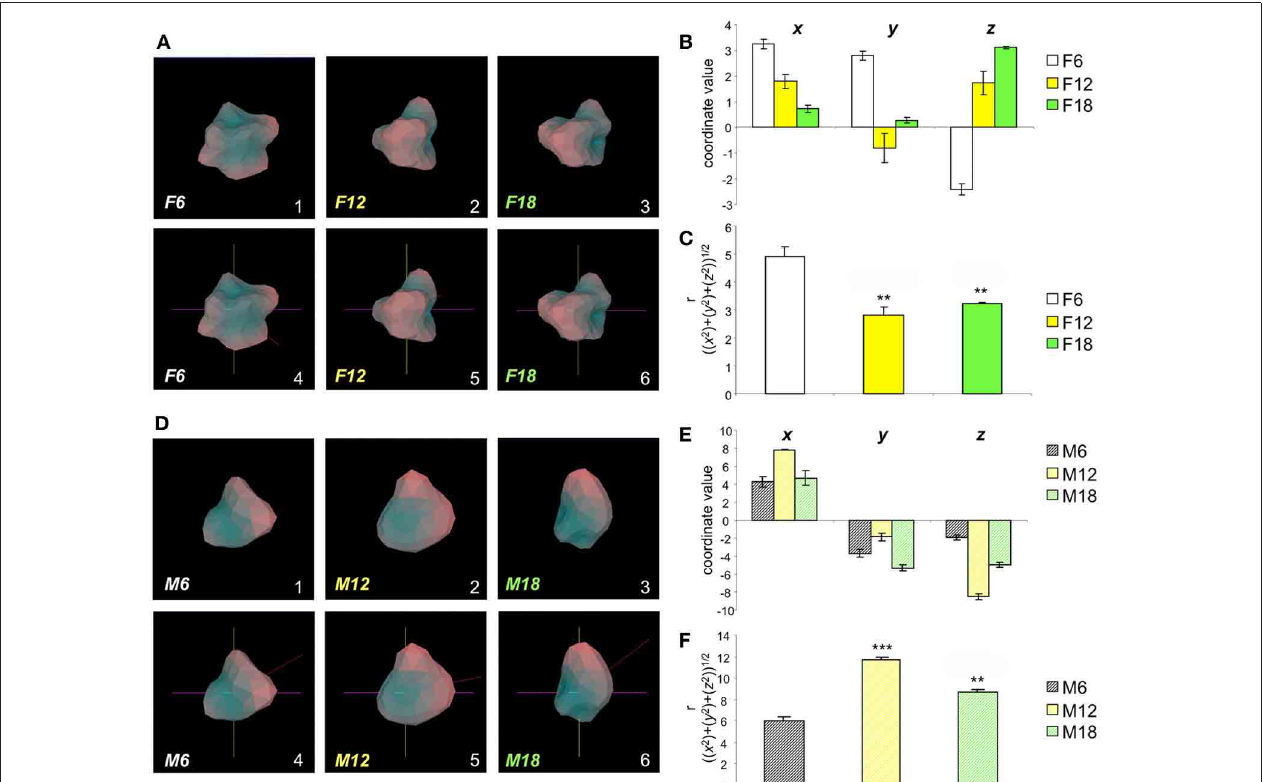
FIGURE 2 | Aging-related structural alteration in hypothalamic Plurigons . (A) Panels 1, 2, and 3 represent plurigons created from hypothalamic transcriptome data from female mice of 6 (F6), 12 (F12), and 18 (F18) months of age, respectively. Panels 4, 5, and 6 indicate the identical coordinate nature of the three plurigons in 1–3. (B) Coordinate values, x , y , and z for the center or mass (COM) for the F6, F12, and F18 plurigons. (C) Calculation of r , ((( x 2 ) + ( y 2 ) + ( z 2 )) 1 / 2 ), for F6, F12, and F18 plurigons. Statistical significance ( ∗ p < 0 . 05, ∗∗ p < 0 . 01, ∗∗∗ p < 0 . 001) was measured with GraphPad Prism (Student’s t -test) for F12 and F18